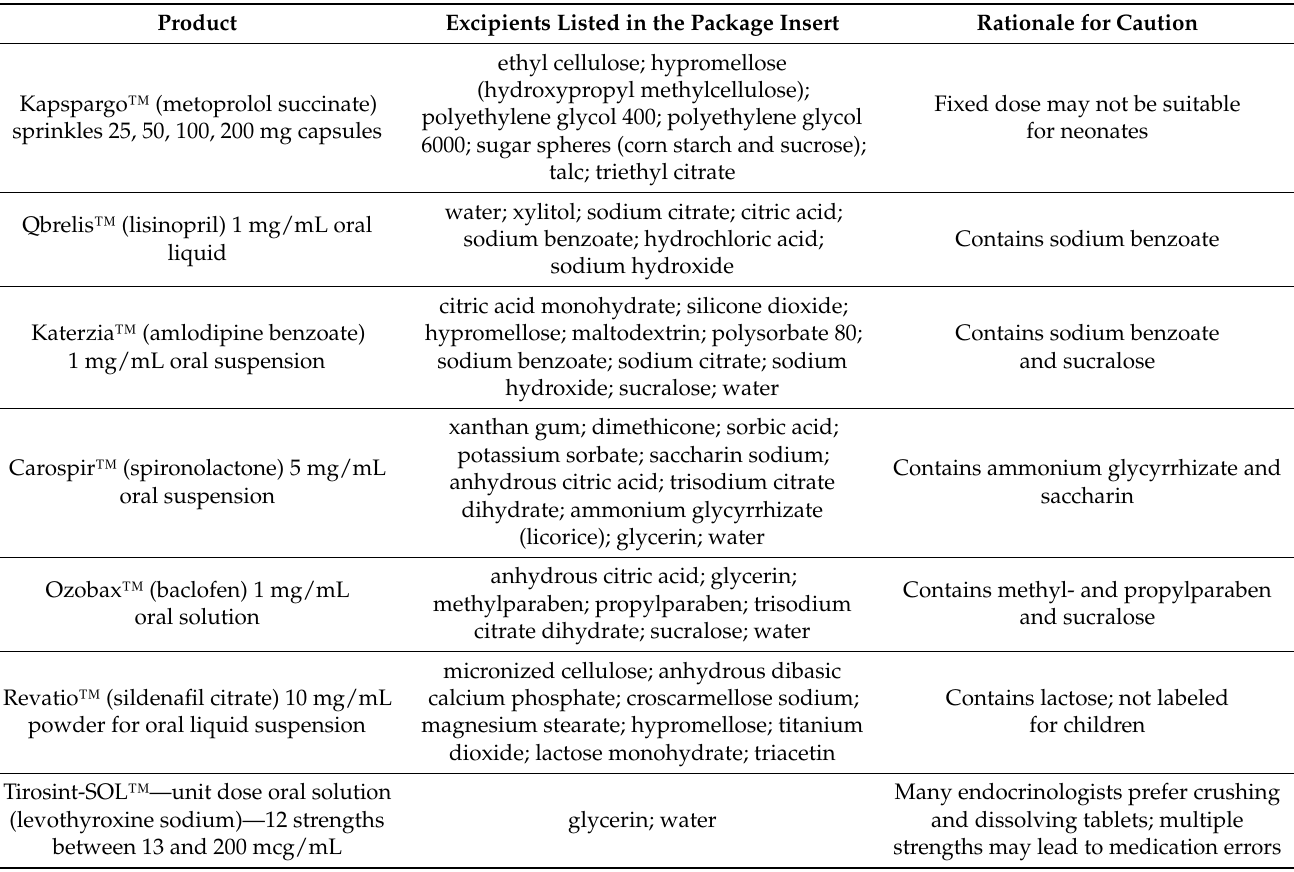
Table 2. Suitability of recently approved and marketed manufactured liquids for